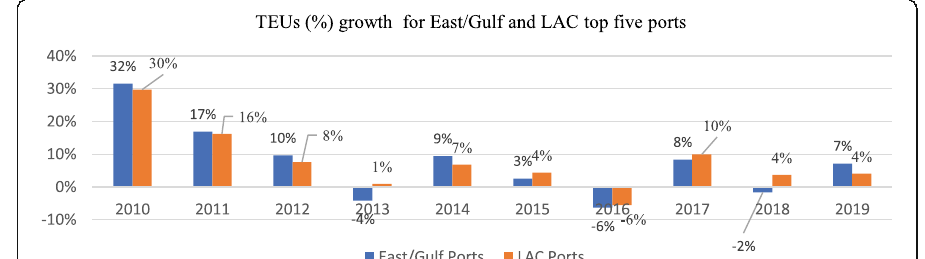
Fig. 2 The top five regional ports for both East/Gulf and LAC TEUs growth (%). Source: Own